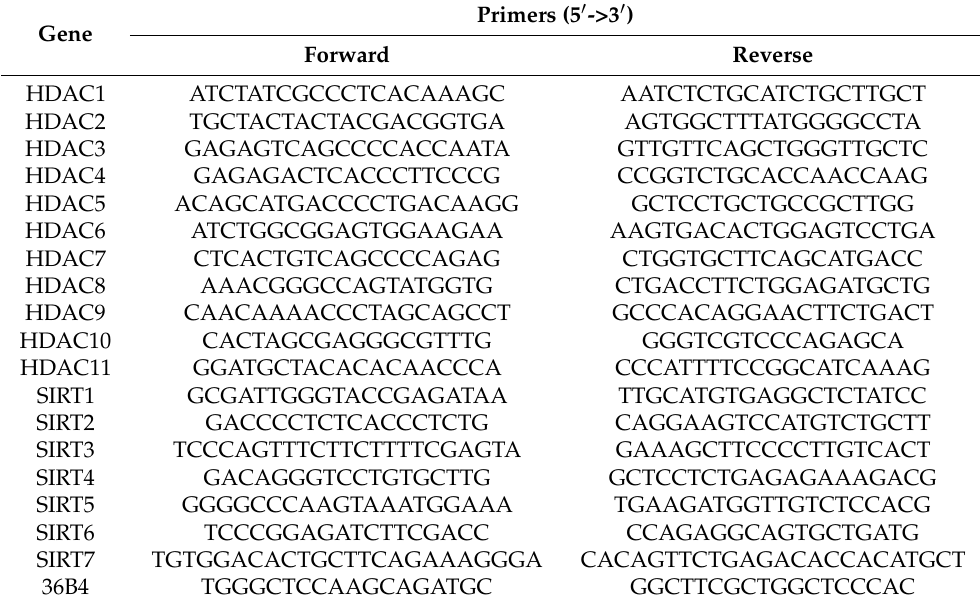
Table 1. Specific primers in used qPCR.